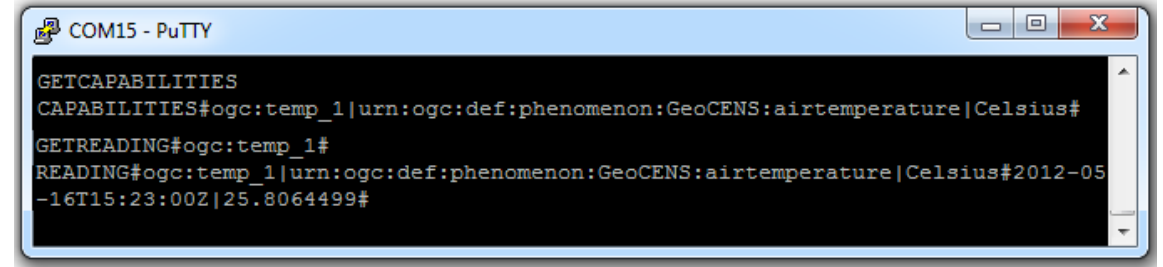
Figure A2. GETREADING request and response to the PUCK-enabled Netduino Plus through Bluetooth.